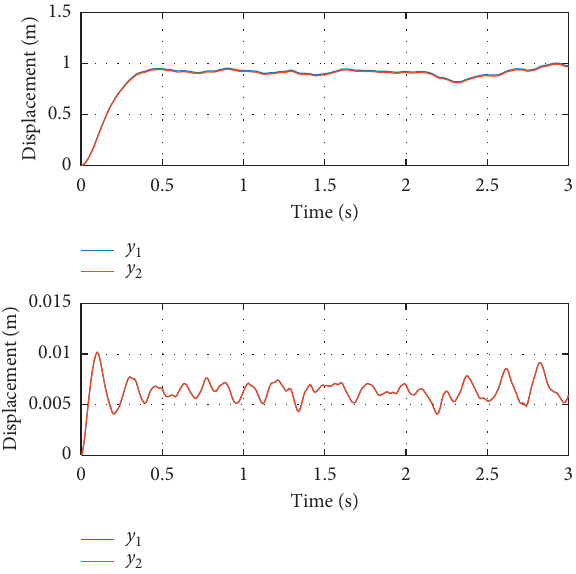
Figure 10: Simulation results under a random signal.